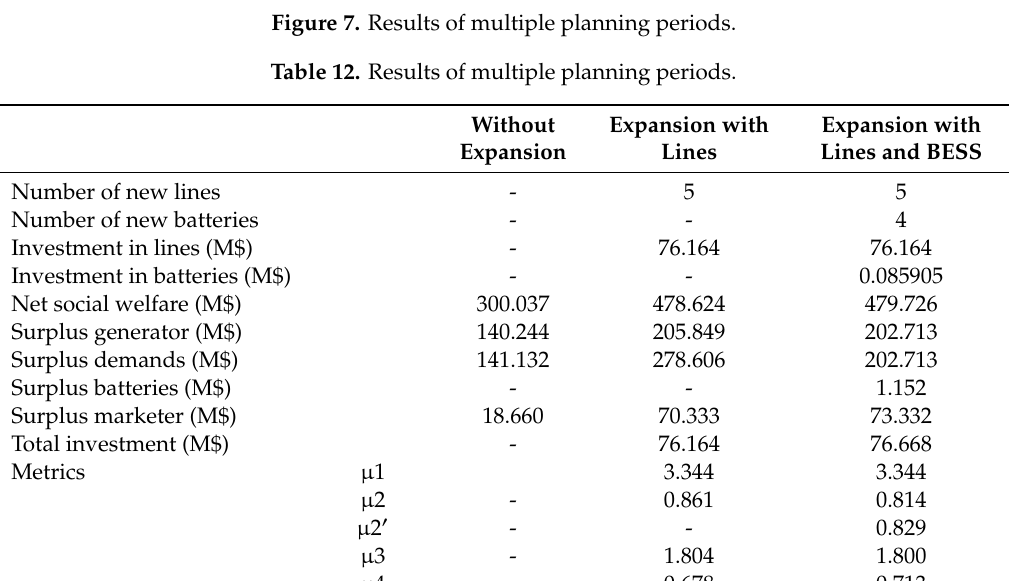
Table 12. Results of multiple planning periods.